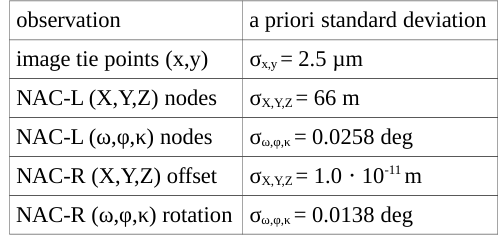
Table 3: A priori standard deviations.